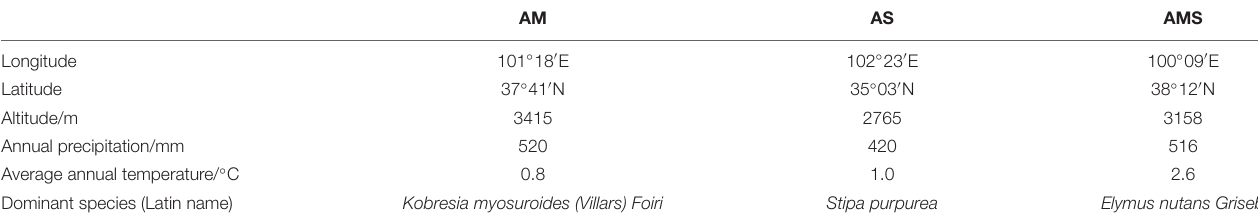
TABLE 1 | Location, climate, and vegetational information of the three sampling